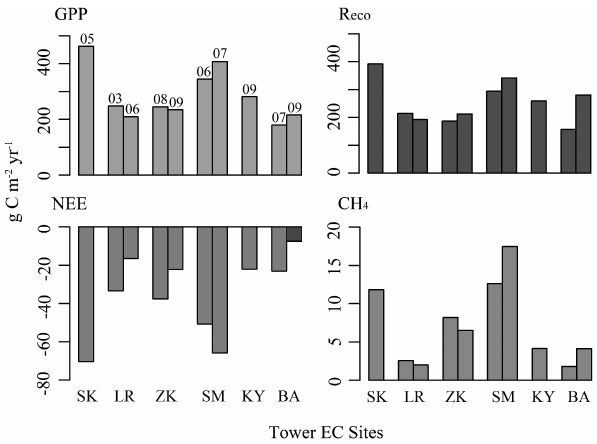
Fig. 8. The TCF model simulation results for cumulative annual GPP, R eco , NEE and CH 4 fluxes determined using satellite remote sensing and reanalysis inputs. For NEE, all sites are net CO 2 sinks except for BA 2009, which is a carbon source (in